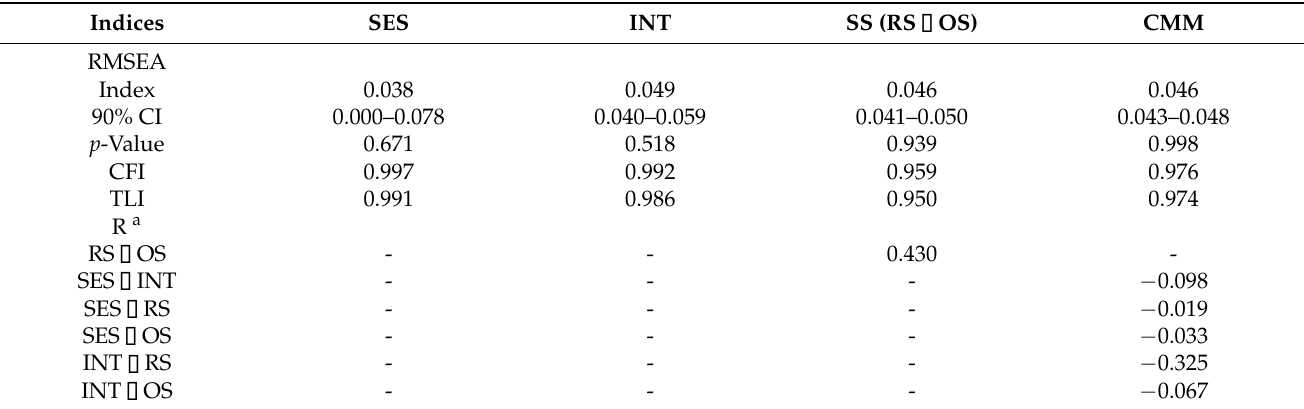
Table 3. Fit indicators of the measuring models, using CMDs as response variable, Brazil, 2020.